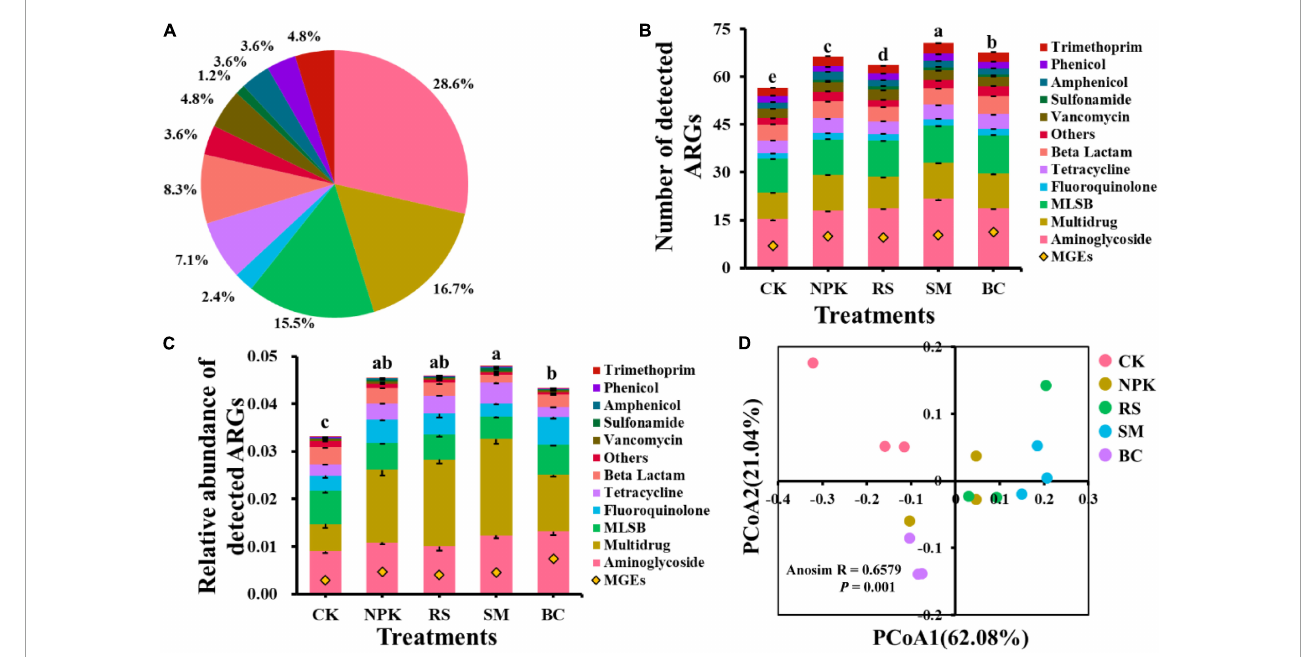
FIGURE1 Classification of ARGs based on the antibiotic to which they confer resistance (A) . Detection number (B) and relative abundance (C) of ARGs categorized by antibiotic type detected in different management practices. The PCoA analysis is based on the relative abundance of ARGs using Bray–Curtis distances (D) . MLSB, macrolide-Lincosamide-Streptogramin B. Different letters above the bars indicate a significant difference ( P < 0.05) across different